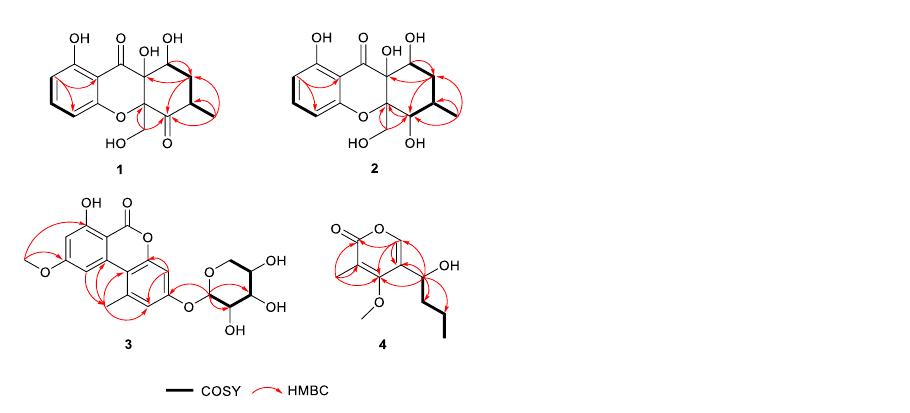
Figure 1. Structures of isolated compounds ( 1 – 12 ).